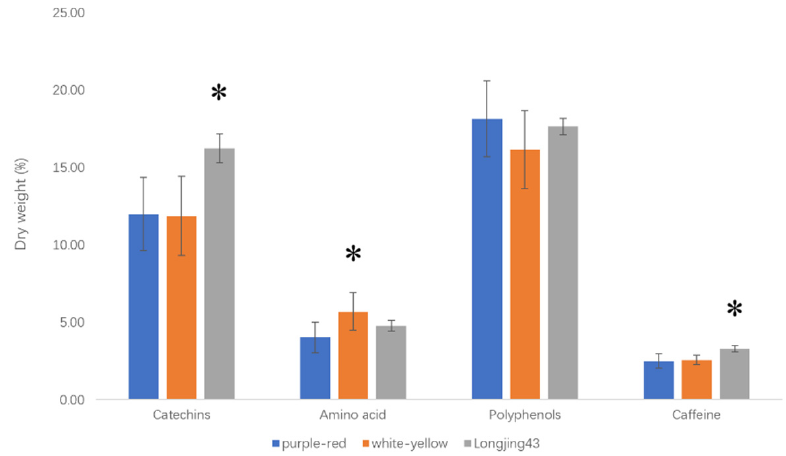
Figure 2. Average total catechin, amino acid, polyphenol and caffeine contents of three different colored-leaf tea types (*: p < 0.05). Table 1. Simple catechin and ester-type catechin contents of three different colored-leaf tea types